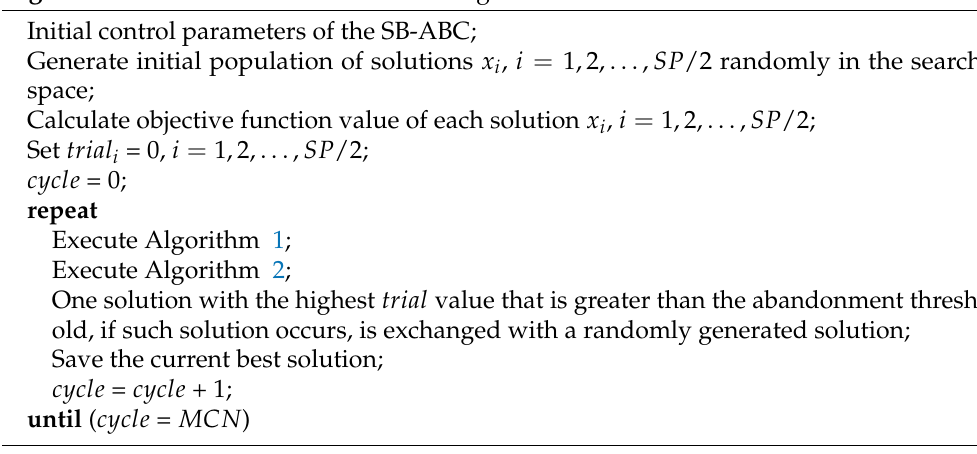
Algorithm 3 Pseudo-code of the SB-ABC